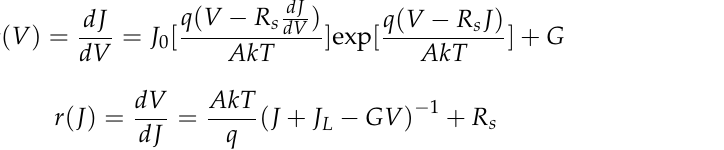
-0.3 -0.2 -0.1 0.0 0.1 0.2 0.3 0.4